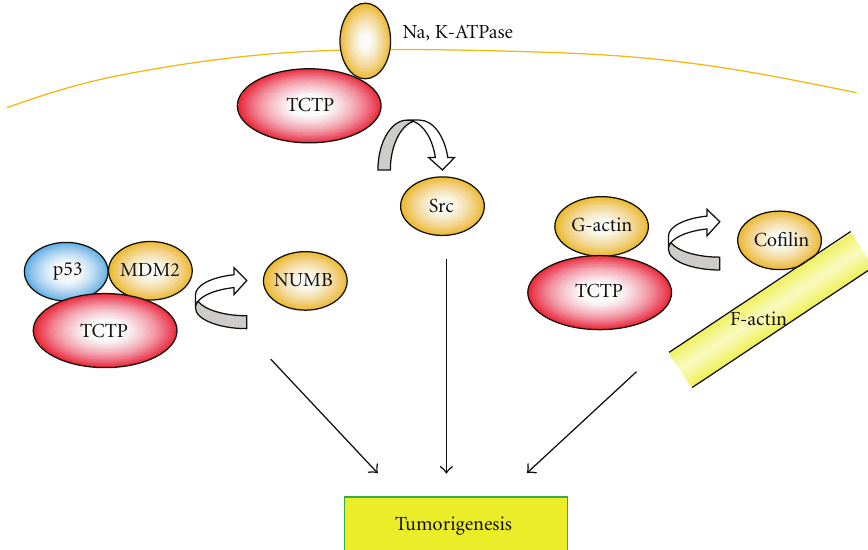
Figure 2: TCTP functions as an oncogene. NUMB forms a tricomplex with p53 and the E3 ubiquitin ligase MDM2, thereby preventing ubiquitination followed by degradation of p53. TCTP promotes p53 degradation by competing with NUMB for MDM2 binding. TCTP binds to Na, K-ATPase and, as a result, it releases Src binding to Na, K-ATPase and activate it. TCTP can release cofilin binding to G-actin by competing with and replacing cofilin. The increase of free cofilin then promotes the binding of the protein to F-actin and exerts its